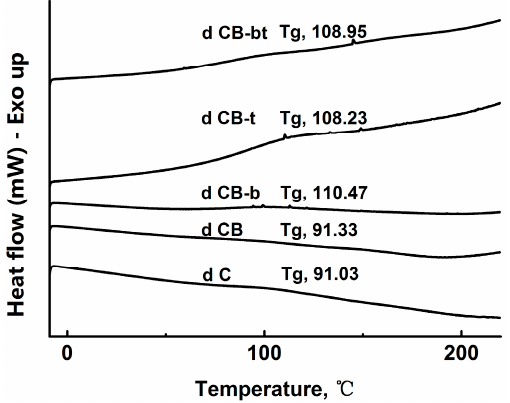
Figure 3. DSC thermograms for cast films C, CB, CB-b, CB-t, and CB-bt.